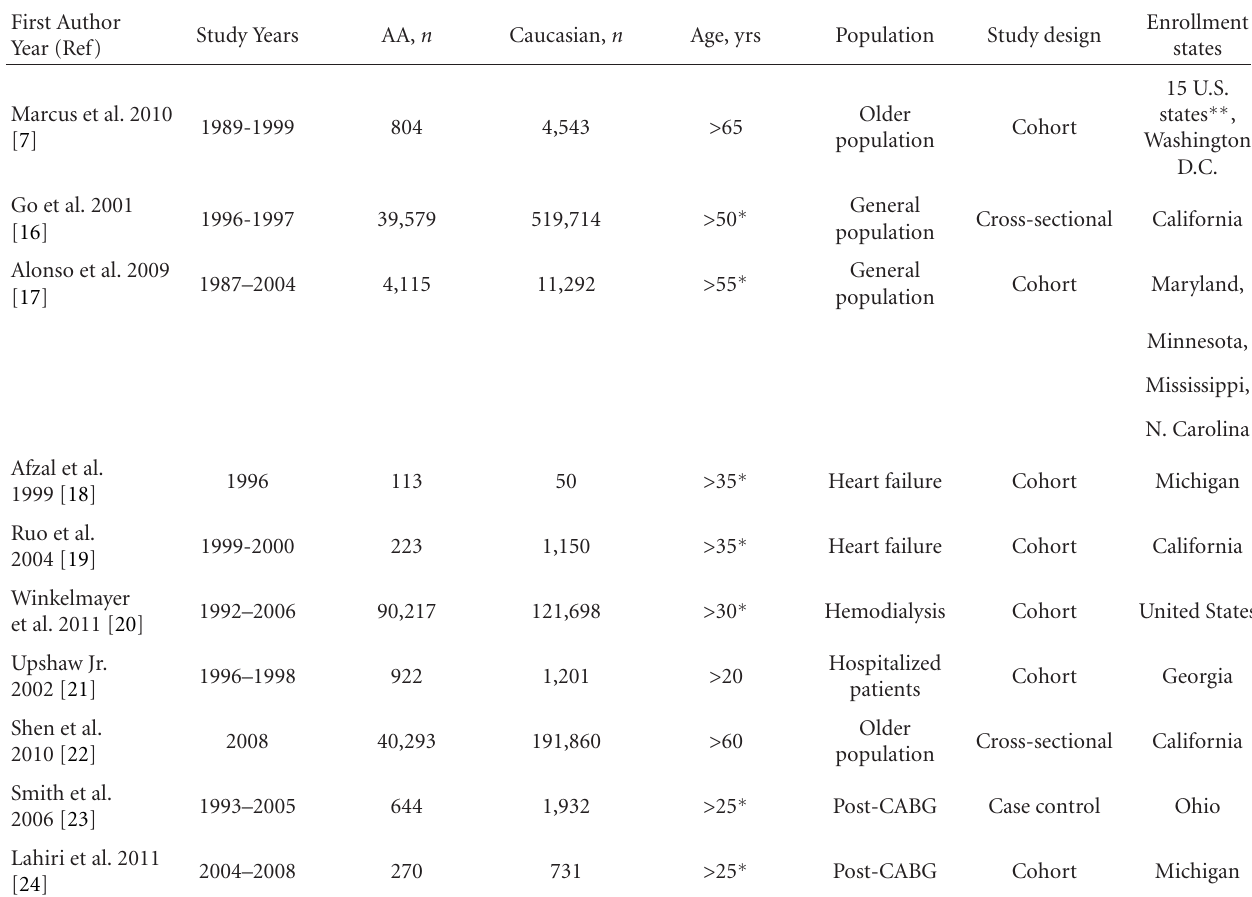
Table 1: Characteristics of included studies in the